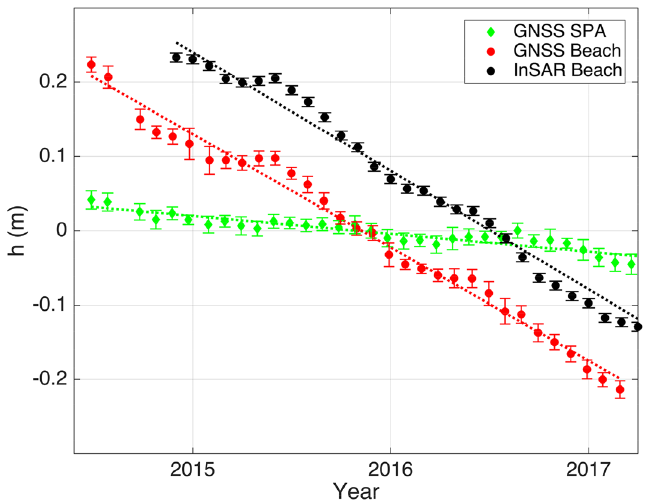
Figure 3. Displacement relative to the middle of the observation period is shown for the GNSS station at the SPA (green symbols) and the Beach stations (red symbols), respectively, between June 2014 and March 2017, in meters. The average subsidence at the SPA is − 2.4 ± 0.7 cm/year that at the beach is − 15.3 ± 1.2 cm/year, respectively. The standard error of the monthly mean GNSS height measurements is ± 1.1 cm. The subsidence at the beach derived from InSAR is − 15.9 ± 1.5